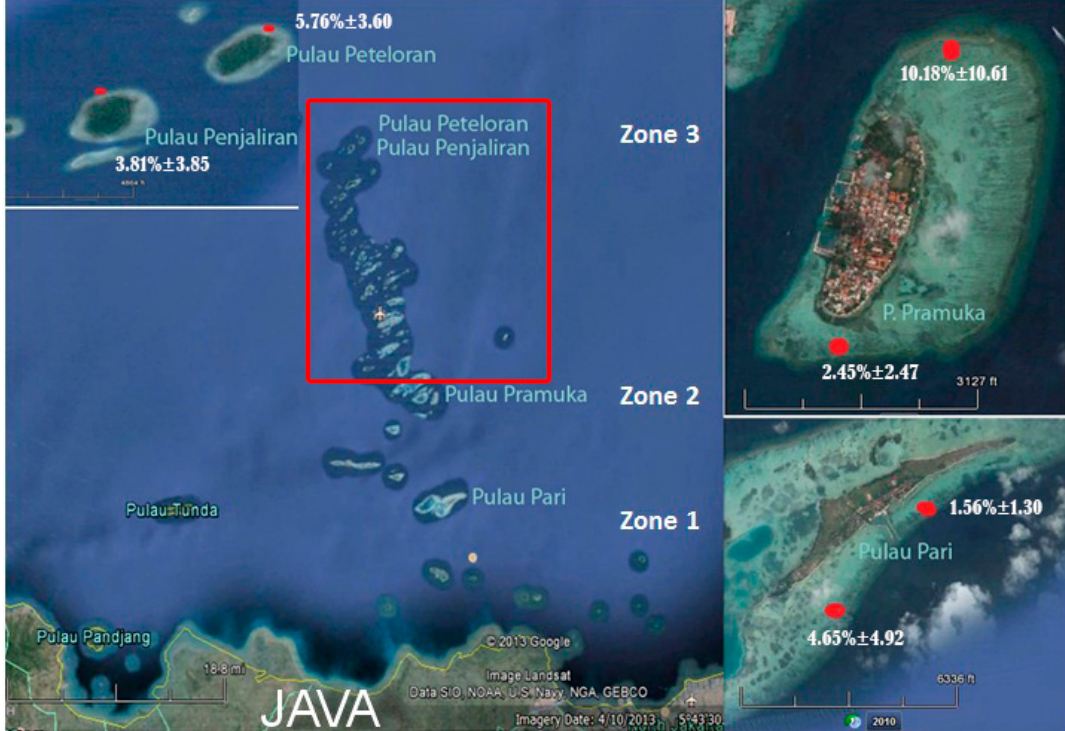
Figure 1. Maps showing the locations of each zone monitored in this study. Zone 1 = nearest sites (Southern Pari and Eastern Pari islands) with a population of 2458. Zone 2 = middle sites (Southern Pramuka and Northern Pramuka islands) with a population of 5123. Zone 3 = farthest sites (Penjaliran and Peteloran islands) as core zone of marine park which no population. The red squares represent the core zone of the Marine National Park area and the red points represent the six study sites with prevalence average of all sampling times of BBD (Source: Google Earth).